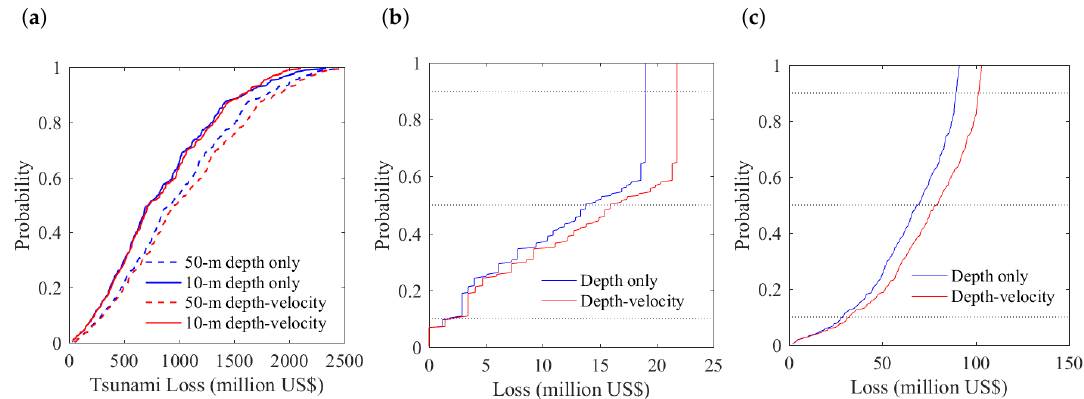
Figure 6. Probabilistic tsunami loss in Sendai: ( a ) all of Sendai; ( b ) RC in region R2; and ( c ) buildings within 1 km from the